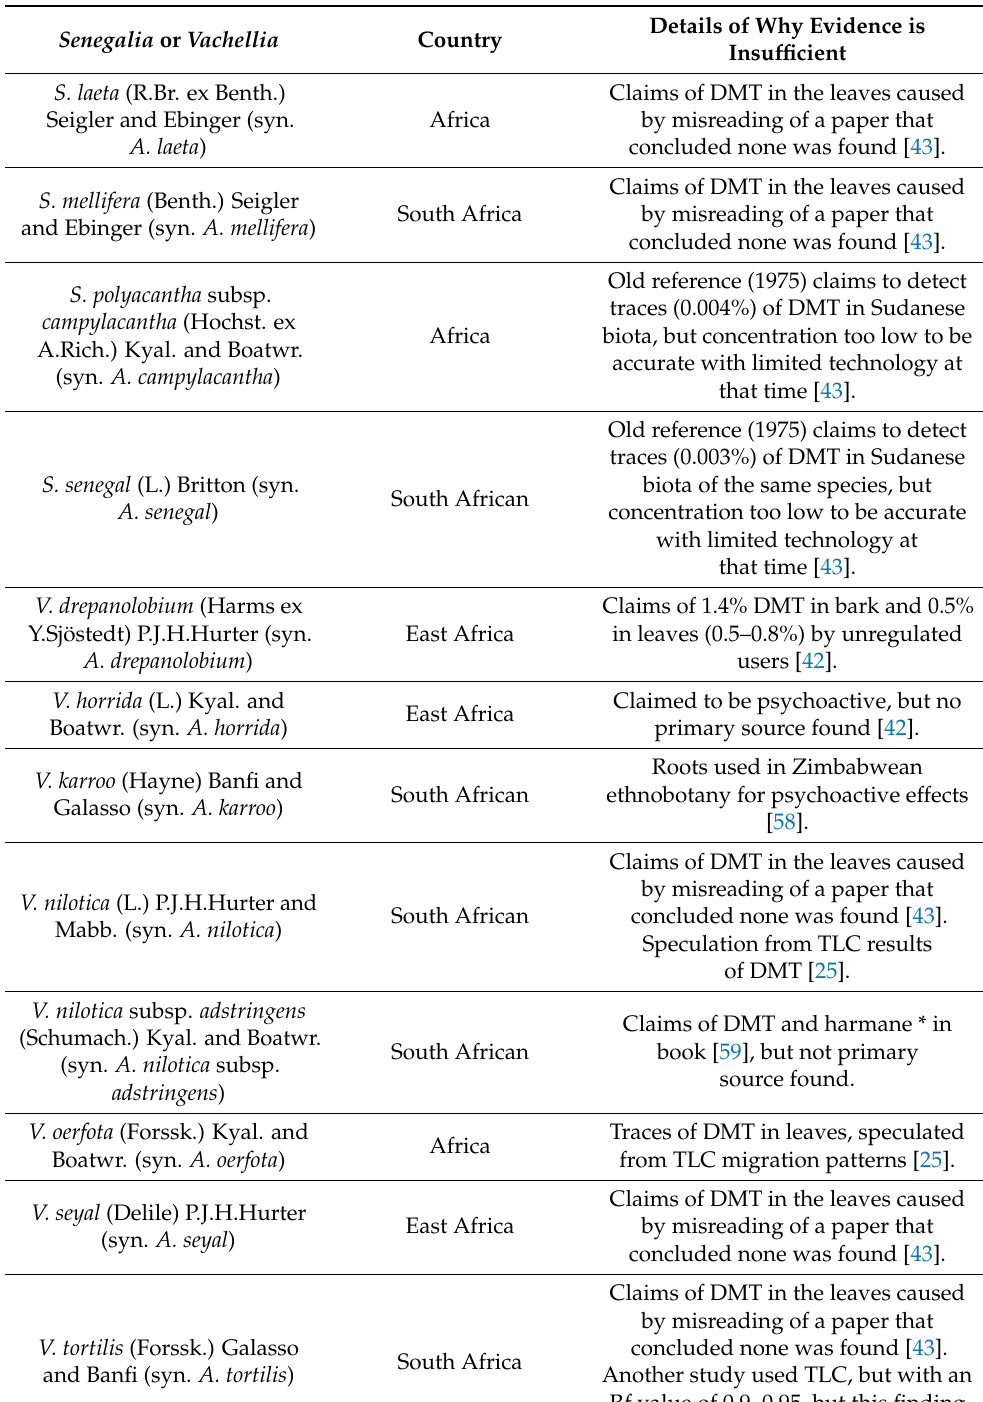
Table 5. The African species of Senegalia and Vachellia that are claimed to be psychoactive or contain psychedelic alkaloids, but the evidence base is un-satisfactory. Senegalia or Vachellia Country